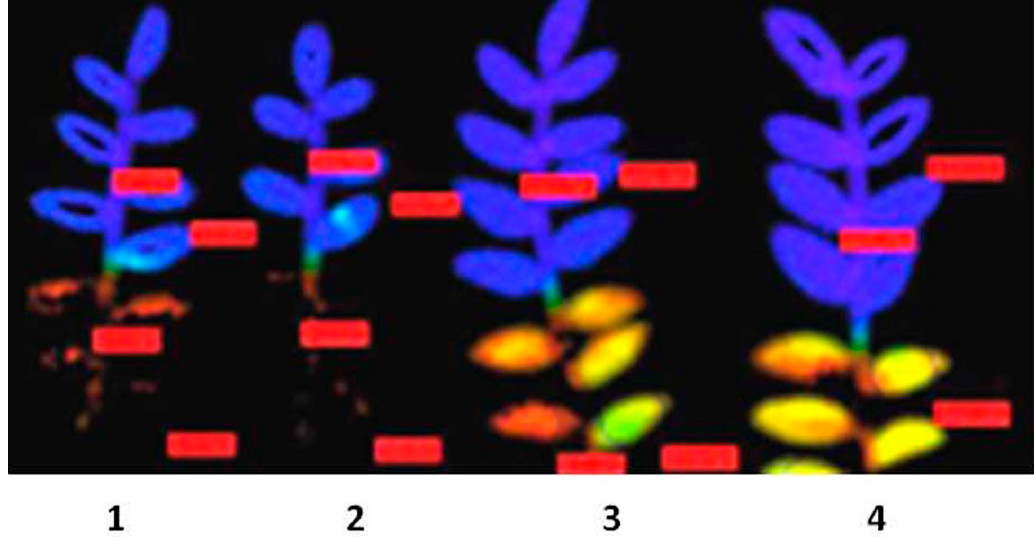
Figure 2. Chlorophyll fluorescence imaging of chickpea leaf for phenotyping heat tolerance. Here upper half of the leaves were not heat treated while bottom halves were heat treated at 46 ◦ C for 1 h. High photosynthetic activity was detected by deep blue colour (higher quantum yield Fv/Fm) while orange, yellow and green or complete black colour represented the diminishing photosynthetic activity. Treated leaves were exposed to saturating light intensity for a fraction of second and depending upon the extent of damage of the photosynthetic system, the emitted light wavelength changed and appeared in different colours. Based on light emission, the probe captured and transformed into different numerical values which were calibrated with different colour codes. The leaf samples 1 and 2 fall in the range of heat sensitive ones as heat treatment completely damaged photosynthetic system either at Photosystem II level or destroying thylakoid membrane restricting electron flow and consequently no images (black) were detected. The leaf samples 3 and 4 were categorized as heat tolerant as they appeared yellow to green in colour indicating lower photosynthesis but still active even after heat shock. The deep blue colour (upper half of all leaves) represented high photosynthesis (non ‐ stressed).